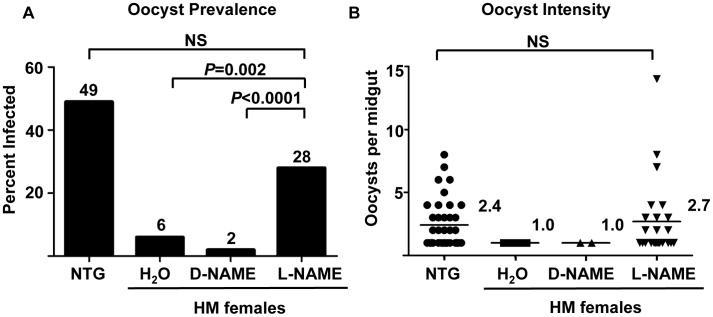
Resistance to P. falciparum in myrAkt HM An. stephensi was reversed by NOS inhibition.Preparation and treatments for mosquitoes is described in the Methods. (A) Prevalence of infection (percentage of mosquitoes dissected with at least one P. falciparum oocyst) of mosquitoes dissected in (B). Fisher's exact test was used to compare treatments against L-NAME; NS = not significant at alpha = 0.05. Numbers above bars reflect mean prevalences for control and treatment groups. (B) Water, D-NAME, L-NAME treatments with myrAkt HM An. stephensi. Age- and cohort-matched NTG control mosquitoes were infected side-by-side with the same parasite culture used for HM myrAkt An. stephensi. Numbers within the figure reflect mean oocysts per midgut for control and treatment groups. This experiment was repeated four times with four separate cohorts of mosquitoes. Data shown are from infected midguts (no zeros). H2O and D-NAME were outside of the 95% confidence intervals for NTG (1.79,3.05) and L-NAME (1.41,4.01); the latter groups were not different by Mann-Whitney U-test (alpha = 0.05).